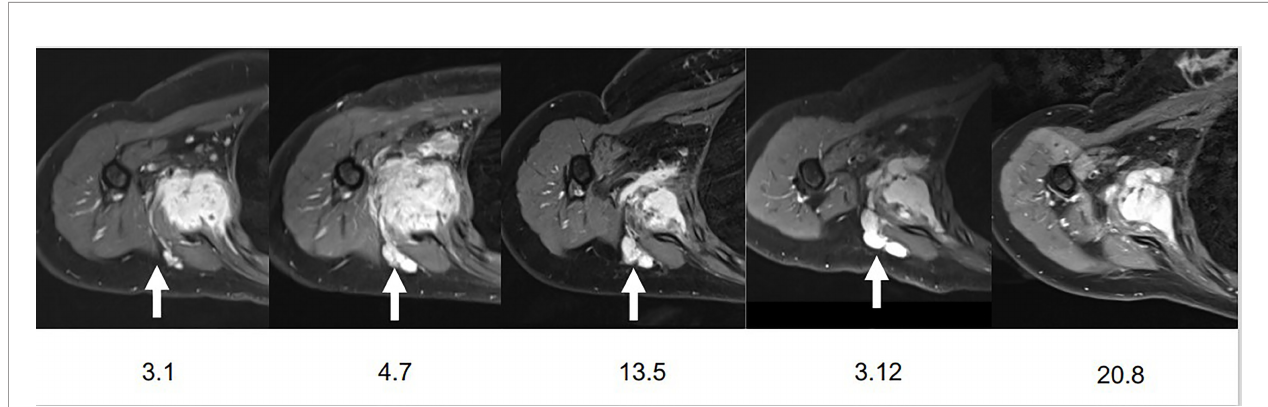
FIGURE 2 | Evolution in time of the axillary lymph